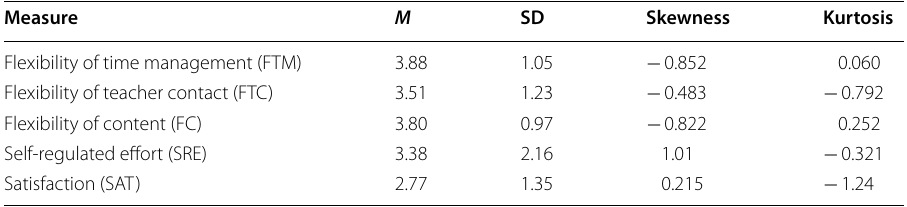
Table 4 Gender differences on flexibility, self-regulated effort, and satisfaction (N